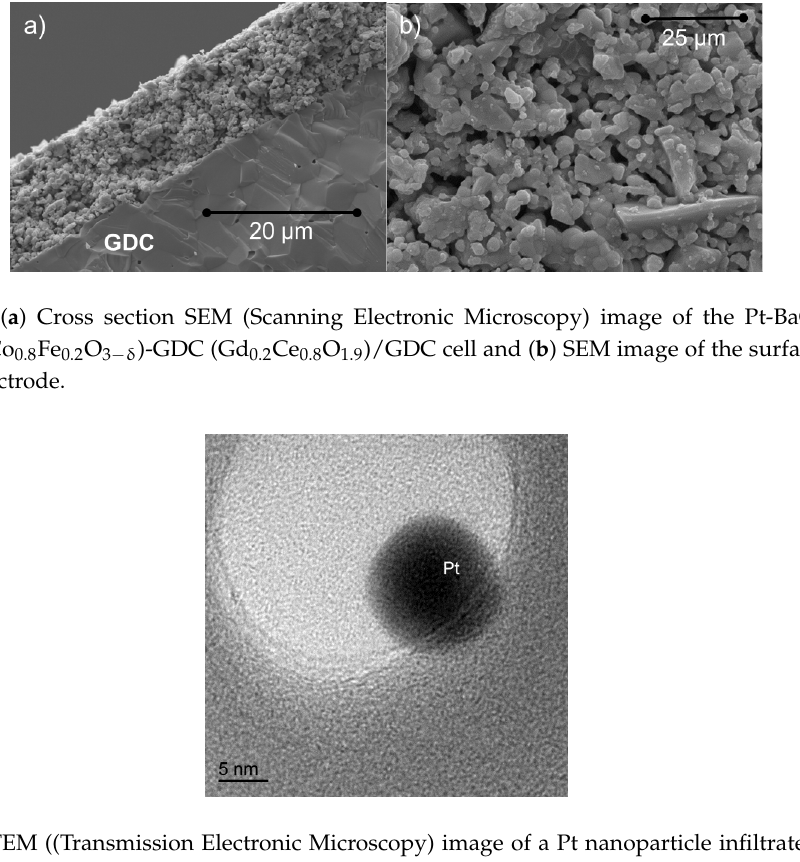
Figure 2. TEM ((Transmission Electronic Microscopy) image of a Pt nanoparticle infiltrated in the catalyst-electrode.